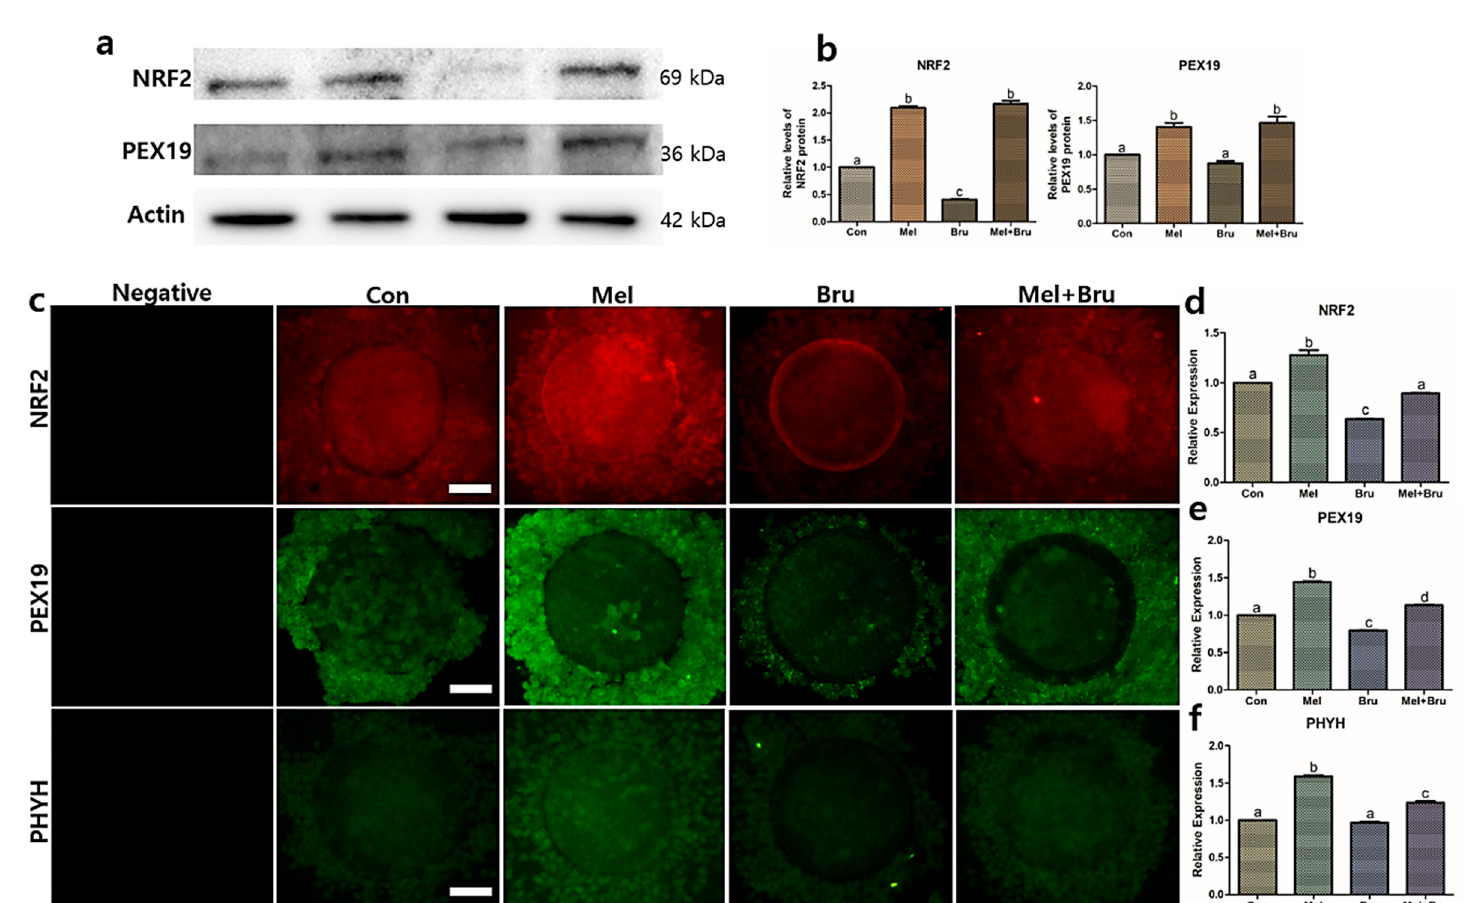
Figure 7. Protein analysis of protein of interest in porcine COCs by immunocytochemistry and western blotting. ( a , b ) Western blot was performed to analyze and quantify NRF2 and PEX19 proteins in the porcine COCs. Beta-actin was used as the reference protein. ( c – f ) In order to re-validate the proteins expressed in the COCs, immunocytochemistry was performed. Bars with letters indicate significant di ff erences ( p < 0.05). Original magnification: 400 × , bars indicate 30 µ m Con; control, Mel; melatonin, Bru; brusatol, and Mel + Bru; melatonin + brusatol. At least three technical and biological replicates were performed.